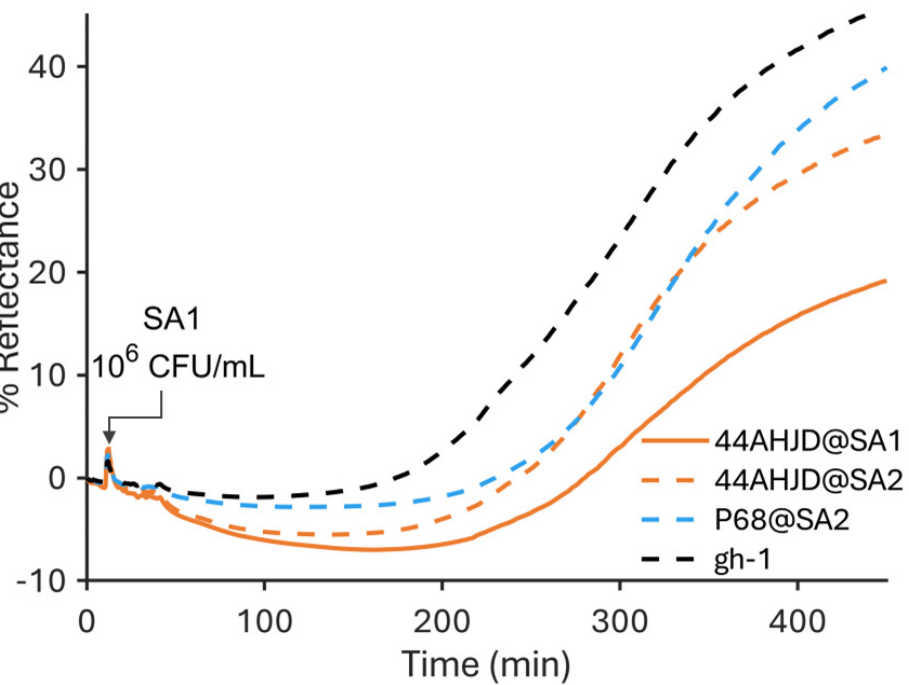
Figure 2. Sensorgram showing the SPR responses of regions functionalized with phages 44AHJD@SA1 (solid orange lines), 44AHJD@SA2 (dashed orange lines), P68@SA2 (blue lines) and gh-1 (black lines) when exposed to S. aureus SA1. Traces show a one-minute rolling average (i.e., mean of 20 data points).